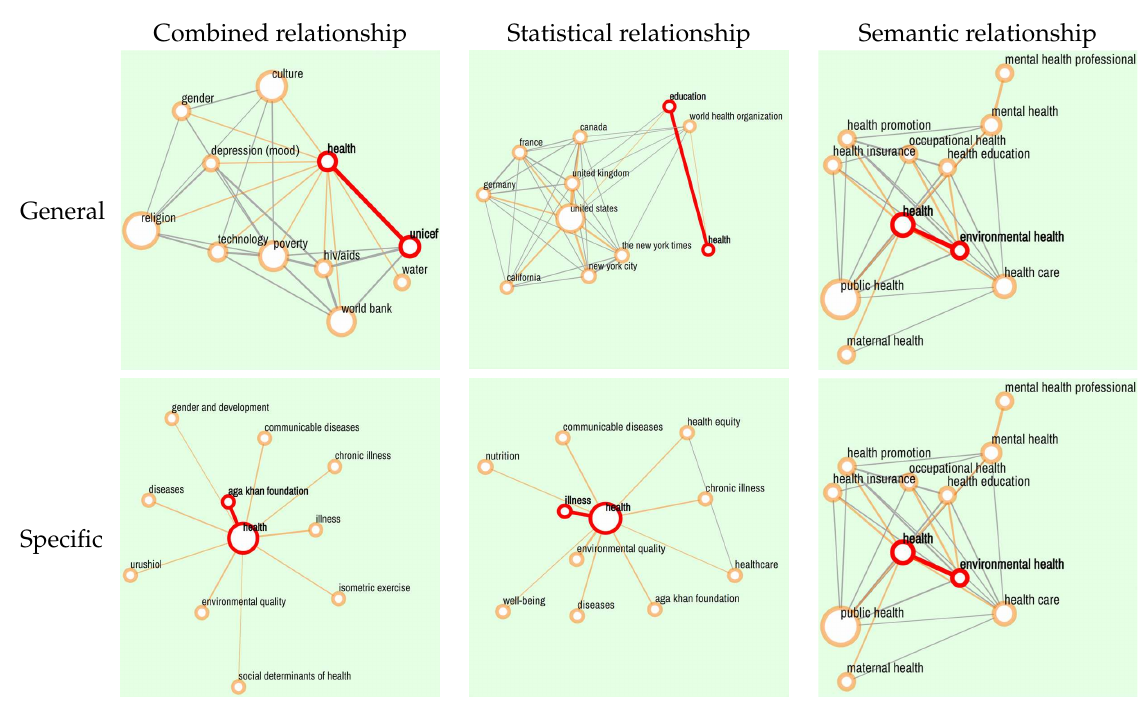
Figure 4. Retrieval results for “health” with three different relationships.